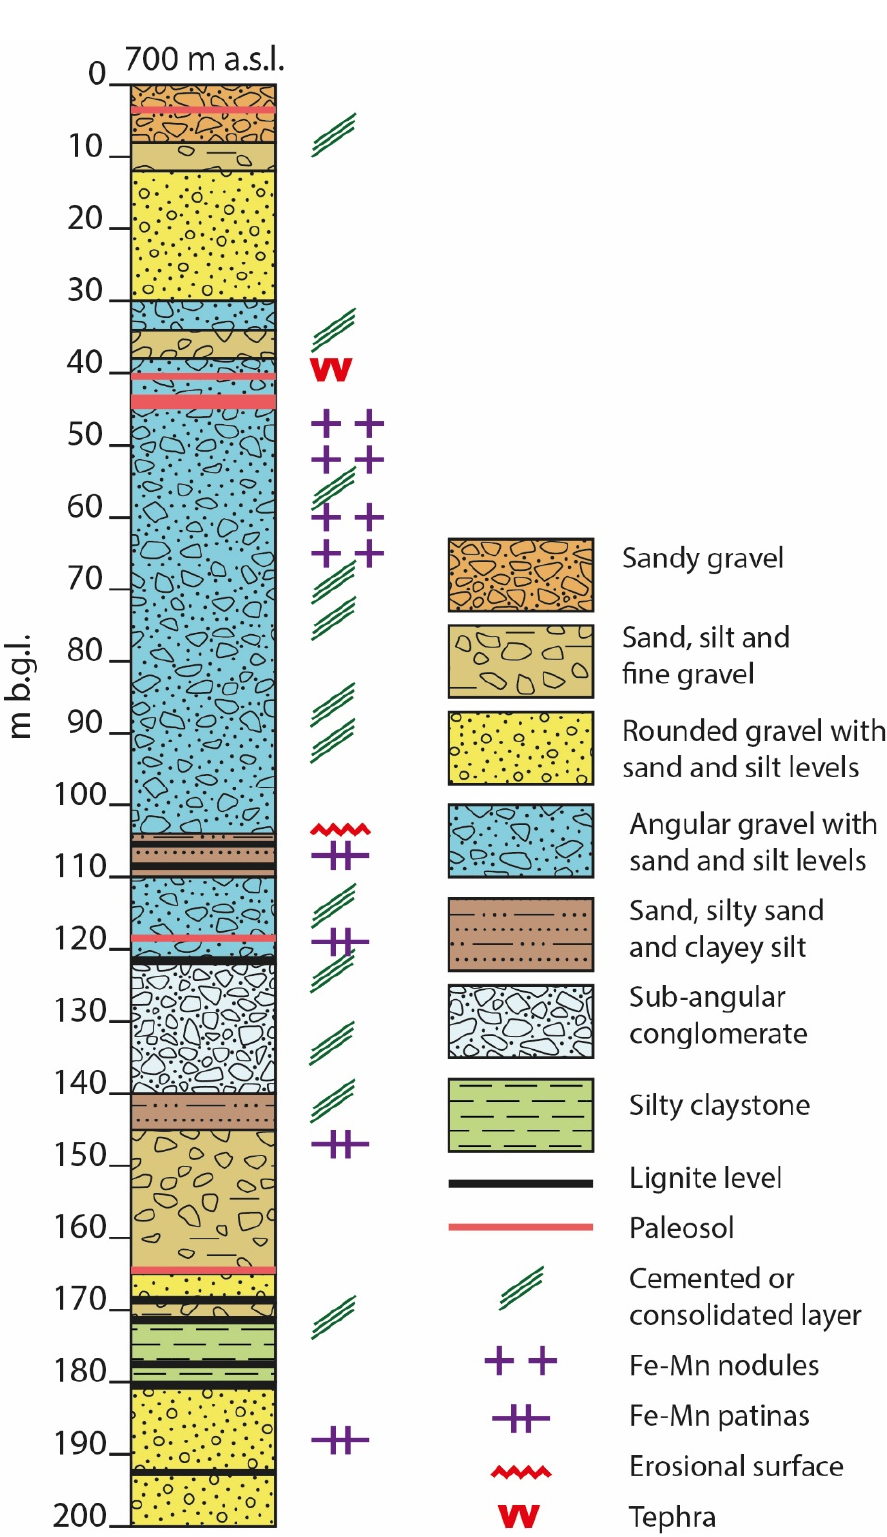
Figure 6. Stratigraphic log of the PB1 borehole (b.g.l.: below ground level).